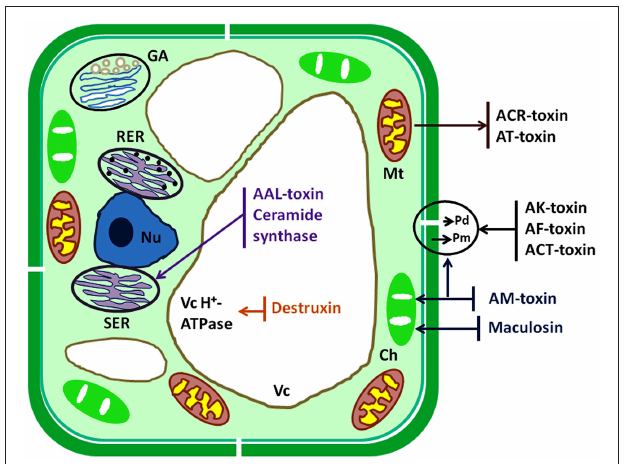
FIGURE 2 | Schematic diagram of target sites of HSTs produced by Alternaria species. Ch, chloroplast; ER, endoplasmic reticulum; GA, Golgi apparatus; Mt, mitochondrion; Nu, nucleus; Pd, plasmodesma; Pm, plasma membrane; Vc,